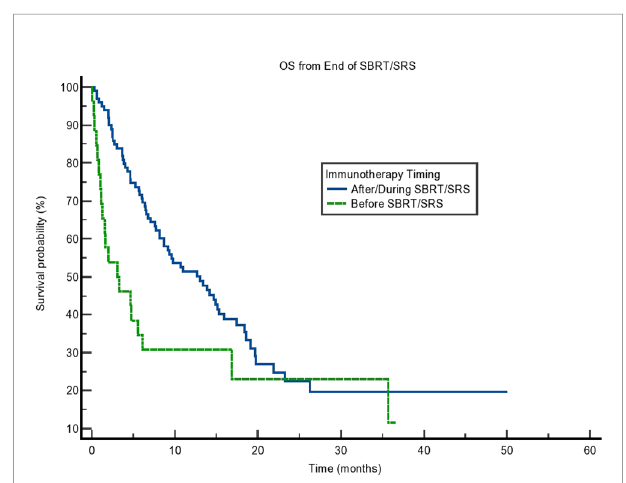
FIGURE 4 | Kaplan – Meier curve showing overall survival (OS) from the end of stereotactic body radiotherapy (SBRT)/stereotactic radiosurgery (SRS) for non- small cell lung cancer (NSCLC) patients only. OS based on immunotherapy given during/after SBRT/SRS compared to before SBRT/SRS. p = 0.16.